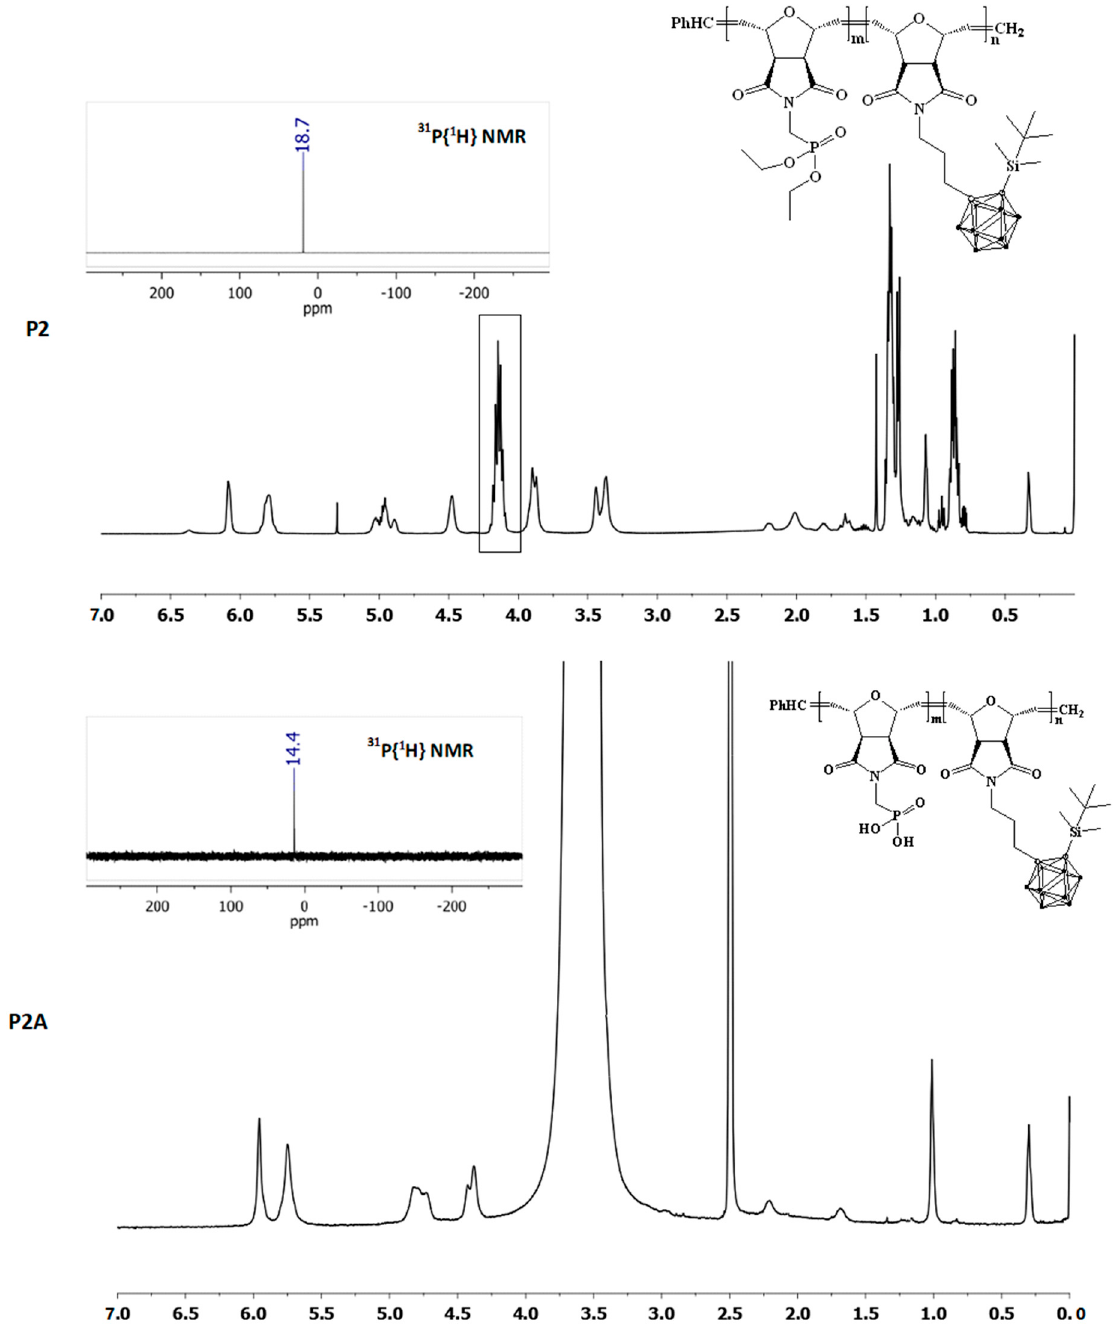
Figure 1. 1 H NMR spectra before and after conversion of the phosphonate ester groups, polymers P2 and P2A (spectrum P2 obtained in CDCl 3 , spectrum P2A in DMSO-d 6 ). The insets are corresponding 31 P{ 1 H}NMR spectra of the respective